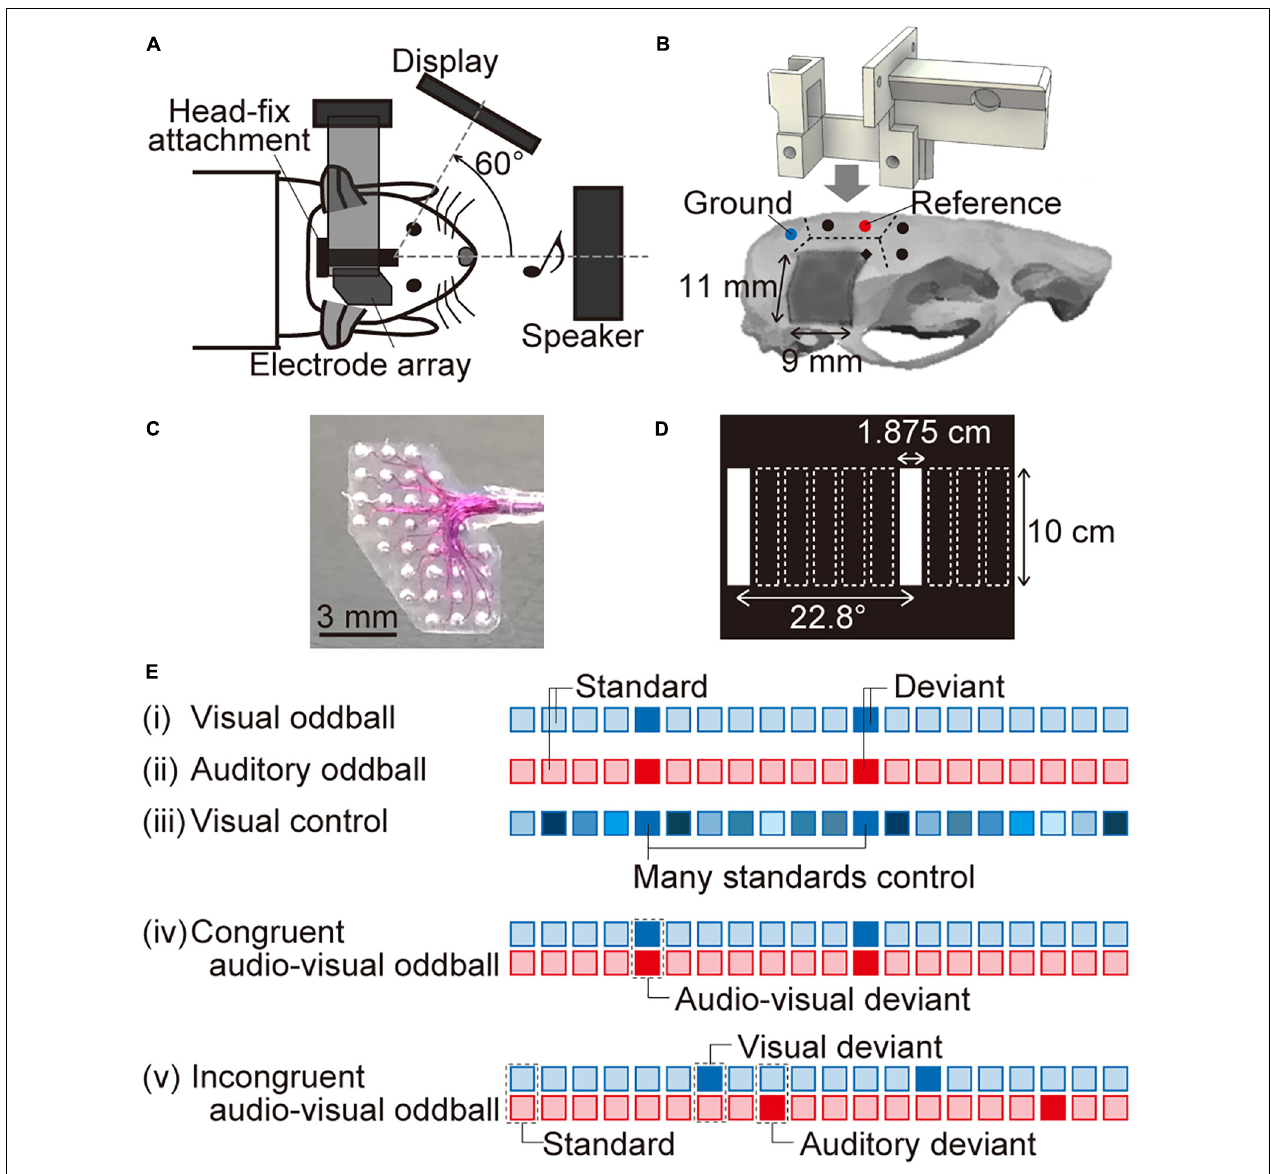
FIGURE 1 | Experimental setup. (A) Schema of the experimental system. A custom-designed head-fix attachment implanted on the skull of each tested animal was used to fix it to the experimental neural recording system. The animals were anesthetized using isoflurane, the right visual and auditory cortices were exposed, and an electrode array was positioned onto the surface of the brain. Visual and auditory stimuli were presented from a display monitor facing an axis 60 ◦ left from the sagittal axis and from a speaker in front of the rat, respectively. (B) The dotted lines indicate the boundaries of the skull. The five circles indicate where the screws (diameter, 1 mm; length, 3 mm) were anchored. Two of these screws made electrical contact with the dura mater for use as the ground and reference electrodes (indicated by the blue and red circles, respectively). The head-fix attachment was fixed on the skull using dental resin. For neural recording, we started drilling into the skull from the point indicated by a black diamond (2-mm posterior and 1.5-mm lateral to the bregma) and removed a part of the right temporal skull (approximately 11 mm × 9 mm, dark gray color). (C) Magnified image of the surface microelectrode array with 32 recording sites. The recording sites in the upper left and bottom right cover the visual and auditory cortices, respectively. (D) In the visual “many standards control” paradigm, white vertical bars (1.875-cm wide and 10-cm high) at 10 different horizontal positions were displayed on the monitor. Two of these positions (i.e., the first and seventh from the left) were also presented in the oddball paradigm. (E) We tested five paradigms to record visual and auditory MMNs. The blue and red squares indicate visual and auditory stimuli, respectively. In (i) the visual oddball and (ii) the auditory oddball paradigm, standard and deviant stimuli were randomly delivered at a 90 and 10% frequency, respectively. (iii) In the visual control paradigm, 10 visual stimuli at different horizontal positions were presented randomly with the same probability as the deviant in the oddball paradigm, i.e., 10%. We also tested two audio-visual oddball paradigms: (iv) in the congruent audio-visual oddball paradigm, visual and auditory deviant stimuli were always presented together, while (v) in the incongruent audio-visual oddball paradigm, they were delivered independently. When the visual and auditory deviant stimuli were presented together in the incongruent audio-visual oddball paradigm, we eliminated the corresponding responses from the analysis. We also performed a second recording for the four oddball paradigms, in which we converted the standard and deviant stimuli to quantify MMN by comparing standard and deviant responses for the same stimuli.